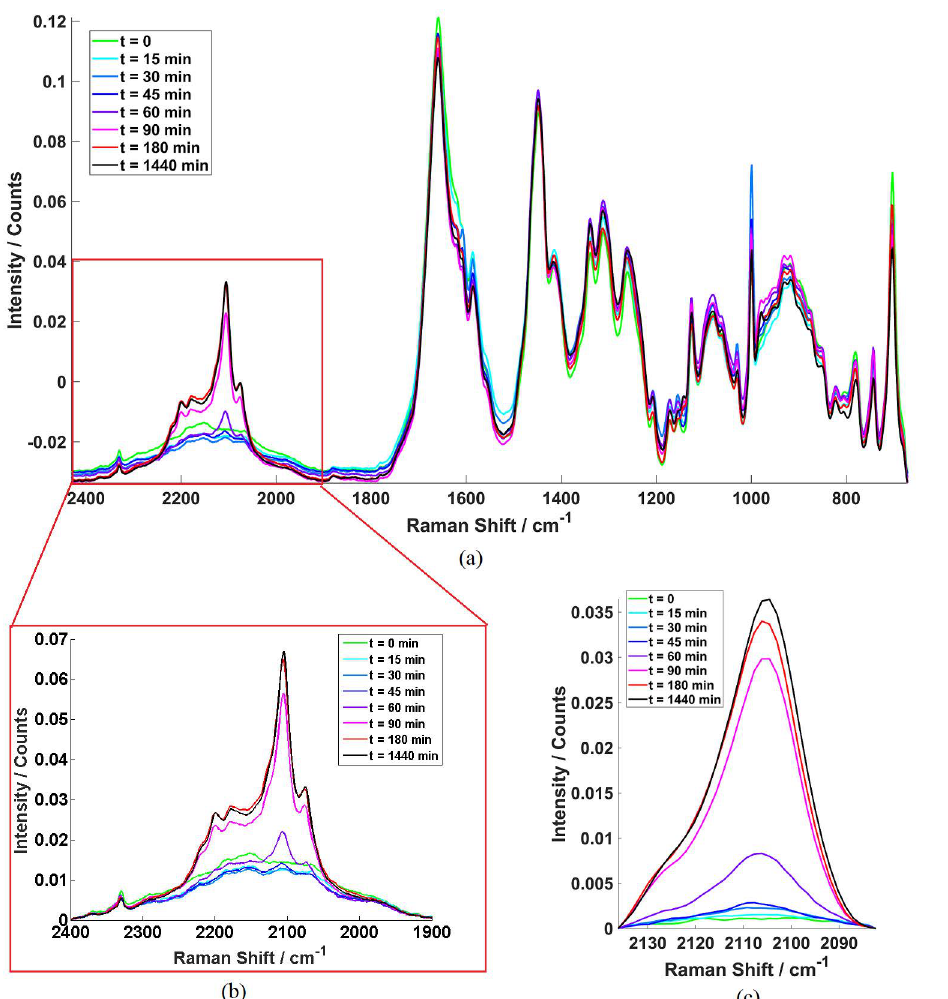
Figure 1. Example mean cell spectra at each time point (PC-3 Cells treated with D31-PA under normoxic condition) with di ff erent Raman shift ranges. ( a ) Full range mean cell spectrum. This contains both the cell information and the CD signal acquired in the ‘silent region’. ( b ) Mean spectra in the CD stretching region (1900–2400 cm − 1 ) zoomed in from ( a ). This contains the whole CD stretch spectral envelope from the D31-PA. ( c ) Mean spectra of the 2106 cm − 1 CD peak used (2082–2136 cm − 1 ). This is the Raman shift region that was used for relative quantification of the D31-PA uptake by the PC-3 cells by calculating the areas under the curve in this